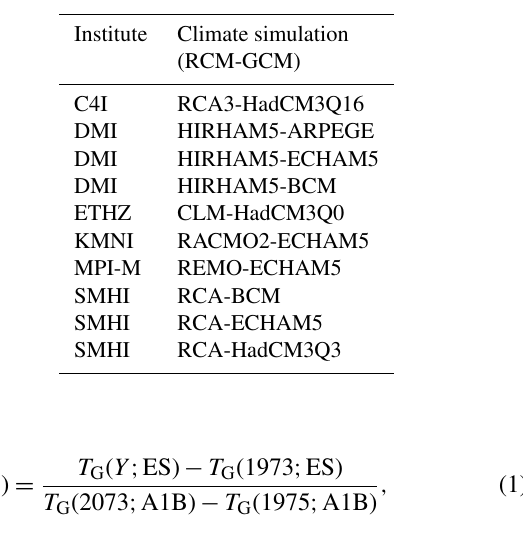
Table 2. Ensemble of climate models (van der Linden and Mitchell,